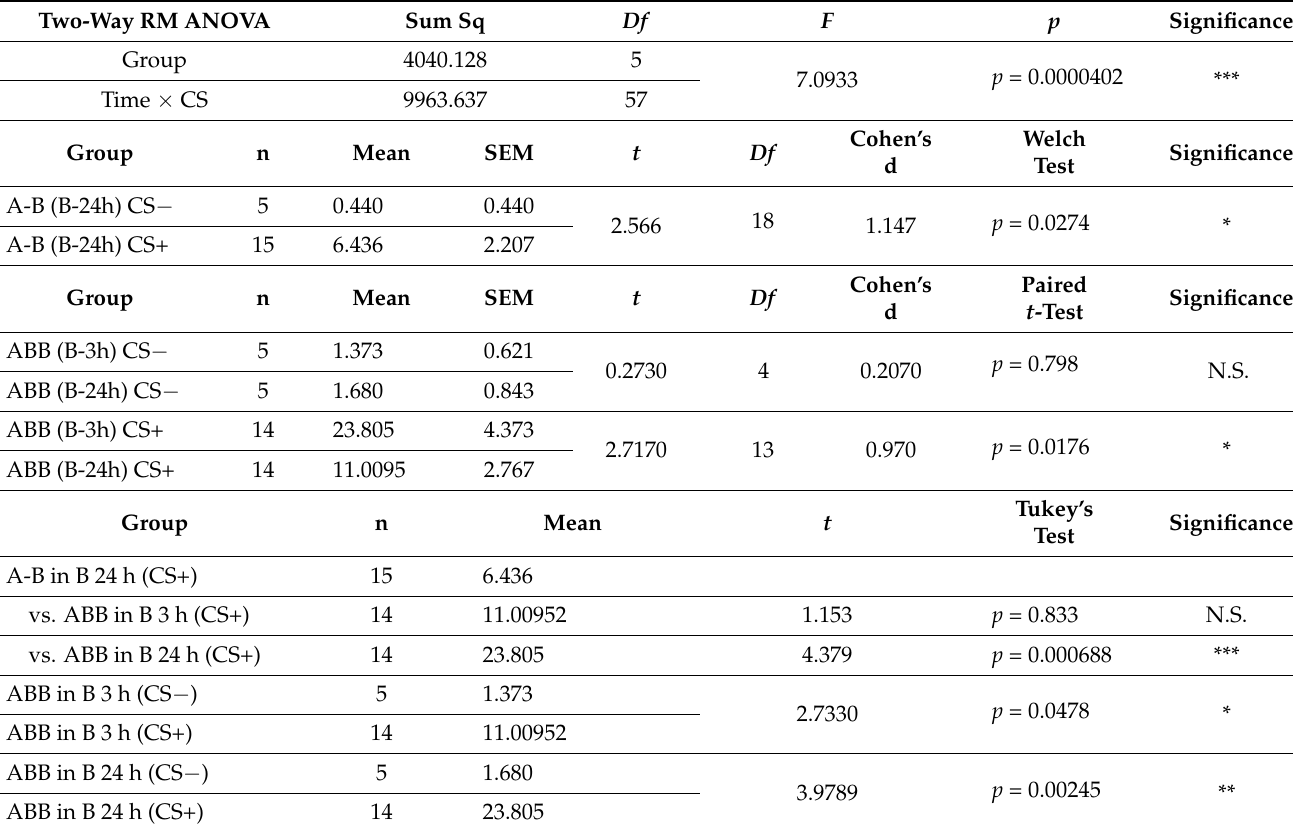
Table 1. Statistical data for Figure